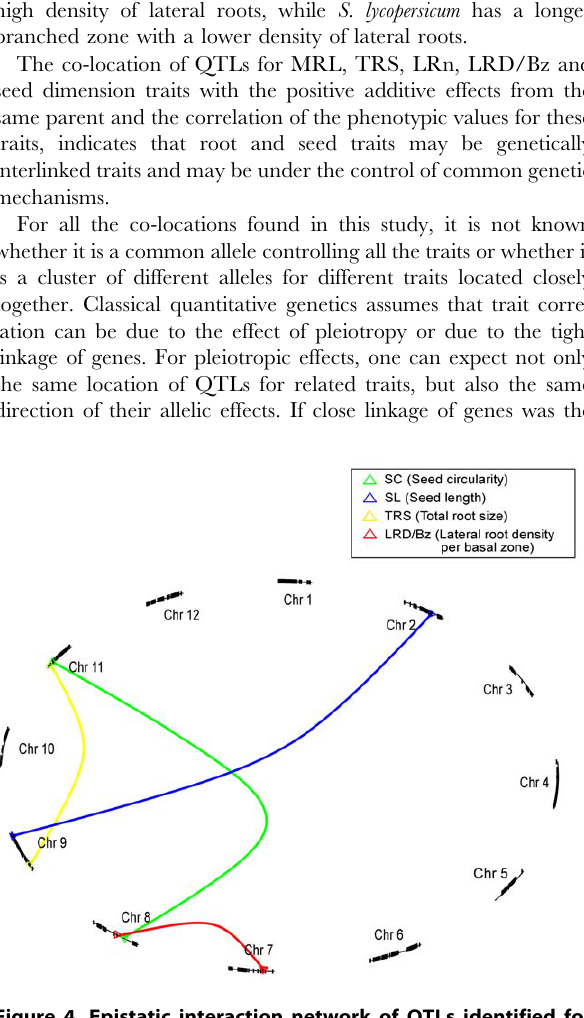
Figure 4. Epistatic interaction network of QTLs identified for seed and seedling quality traits. Graphical visualization of the epistatic interactions observed among different loci controlling seed and seedling quality phenotypes. The 12 chromosomes are represented as different circle segments, and their sizes are proportional to the corresponding genetic sizes measured in cM. The colour of the lines indicates the trait for which the epistatic interaction was observed [86].